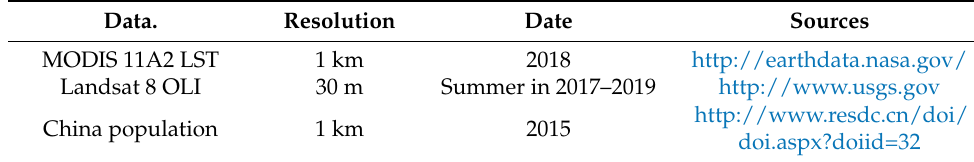
Table 2. Data used in this study.